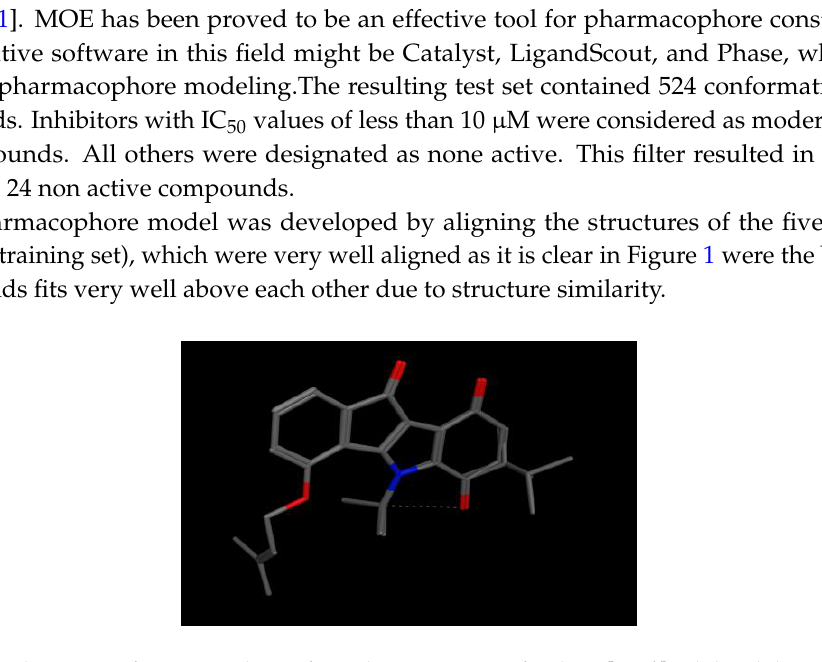
Figure 1. Alignment of compounds 1 – 5 from the training setof indeno [1,2- b ]indole inhibitors of CK2, carbon atoms are in gray, oxygen atoms are in red, nitrogen atom in blue and intermolecular H-bond in dots.